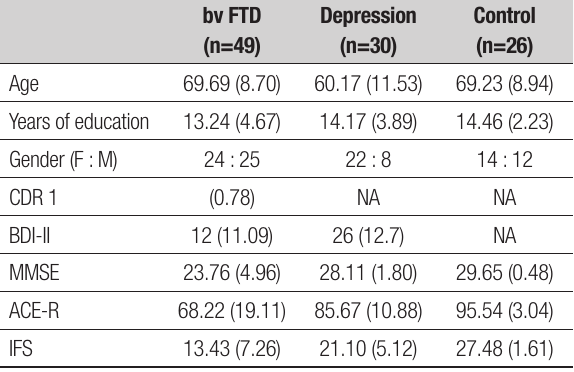
Table 1. Demographic profile and performance on cognitive screening tools. Values are expressed as Mean (SD).